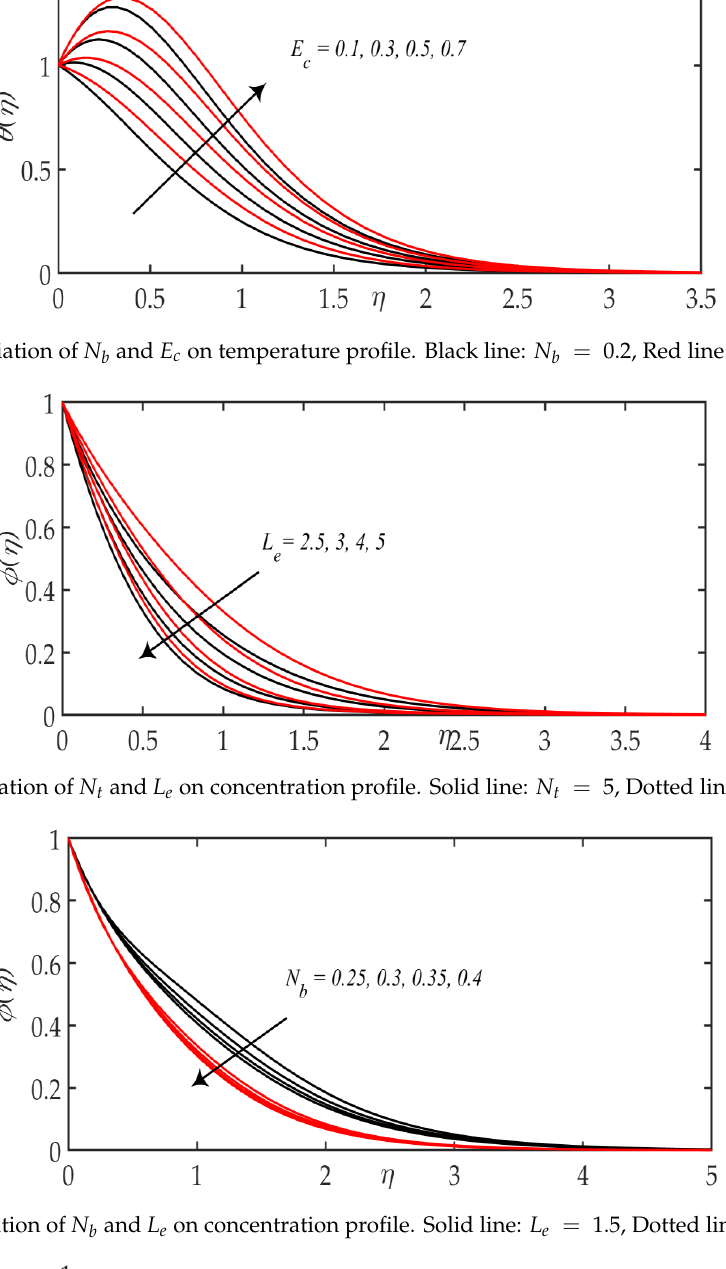
Figure 6. Variation of 𝑁 𝑏 and 𝑁 𝑡 on temperature profile. Black line: 𝑁 𝑏 = 0.2 , Red line: 𝑁 𝑏 = 0.5.